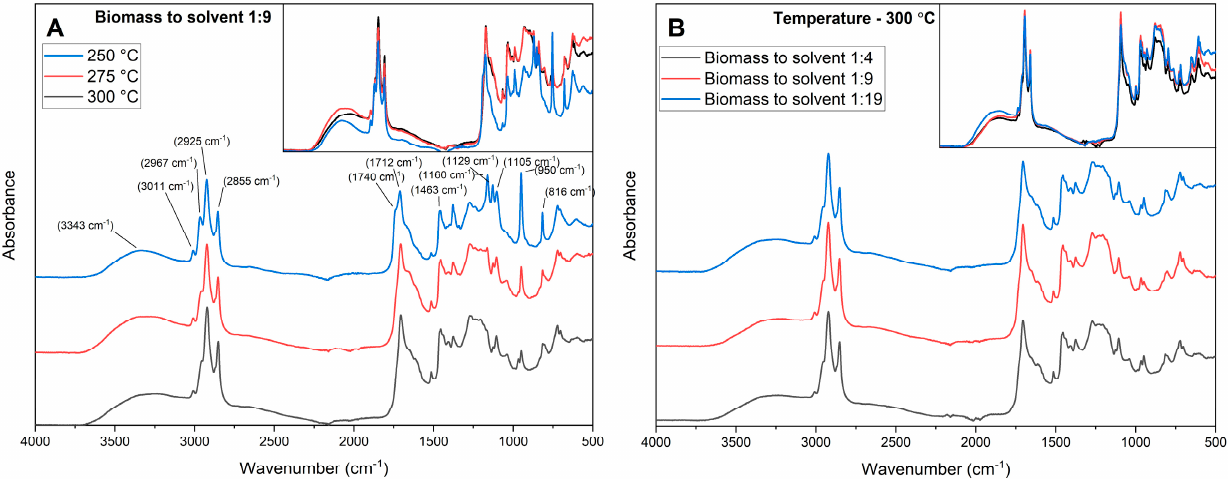
Figure 4. ATR-FTIR spectra of biocrudes obtained at different processing temperatures ( A ) and biomass-to-solvent ratios ( B ).